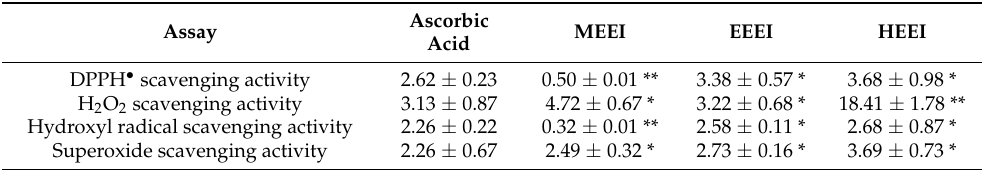
Table 4. IC 50 values (in µ g/mL) obtained from the free radical scavenging assays with ascorbic acid and the Enteromorpha intestinalis extracts. Ascorbic Assay